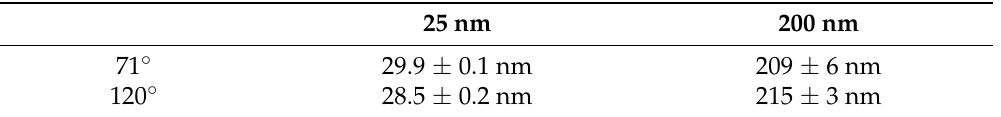
Table 1. Results of the dynamic light scattering measurements using two different polystyrene latex standards diluted in water with nominal radii of 25 nm and 200 nm,